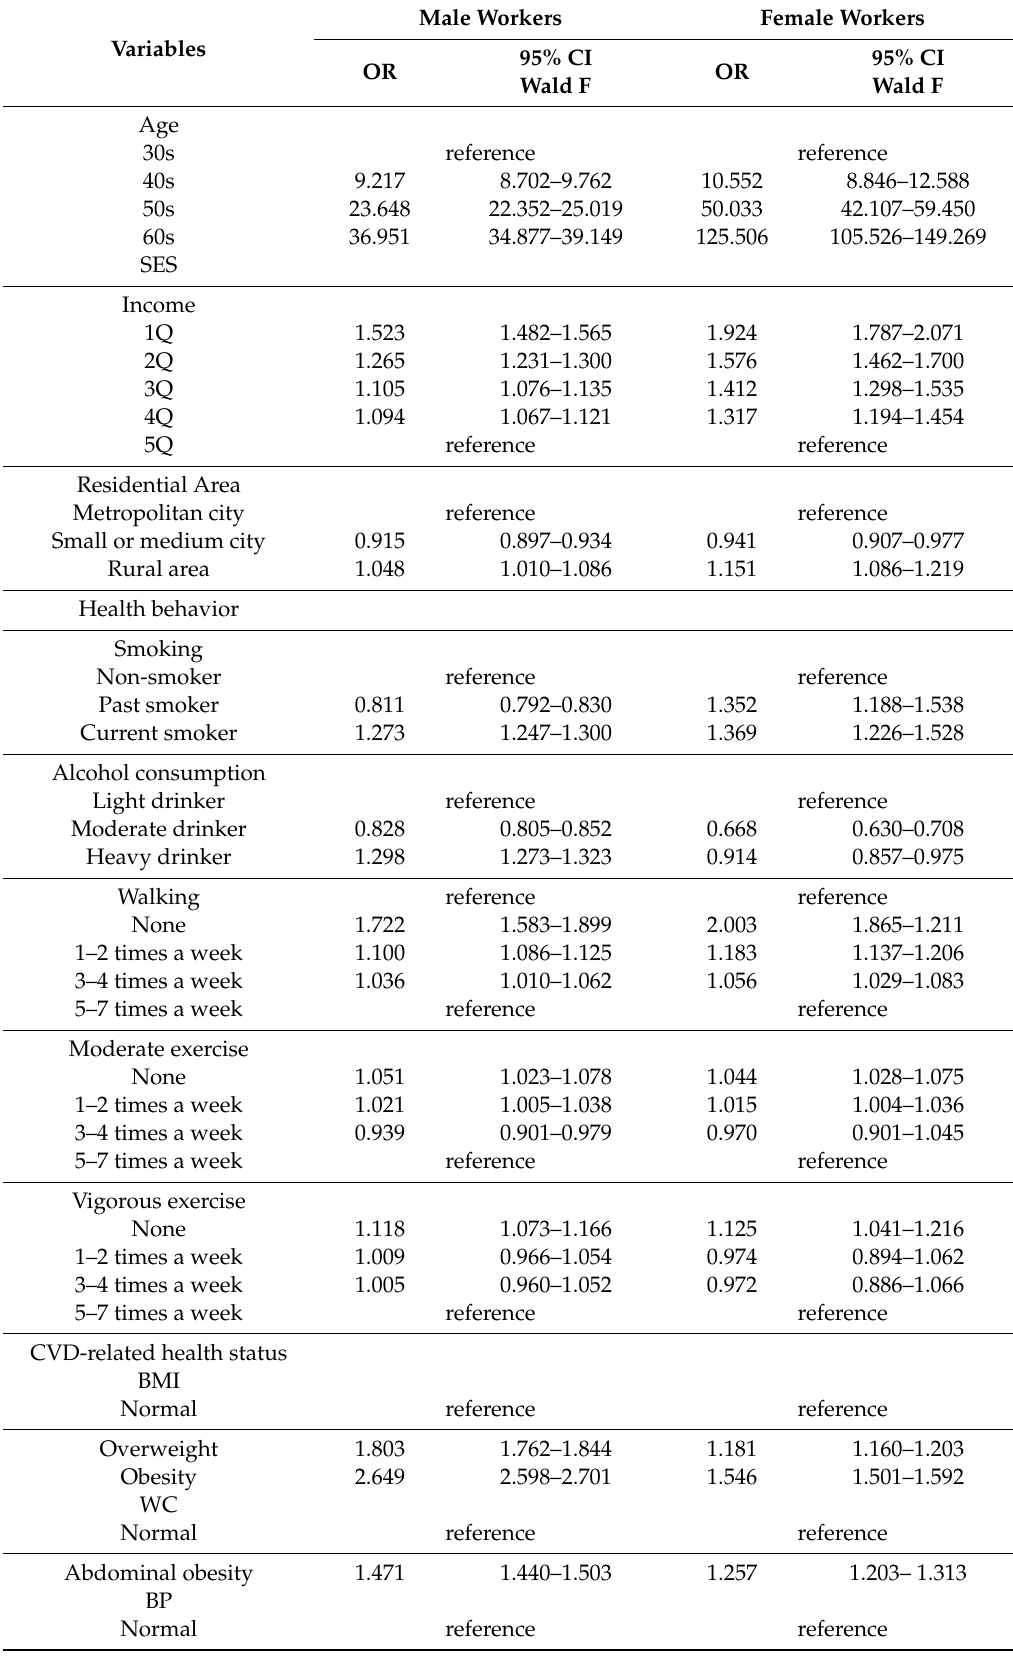
Table 8. Factors influencing CVD